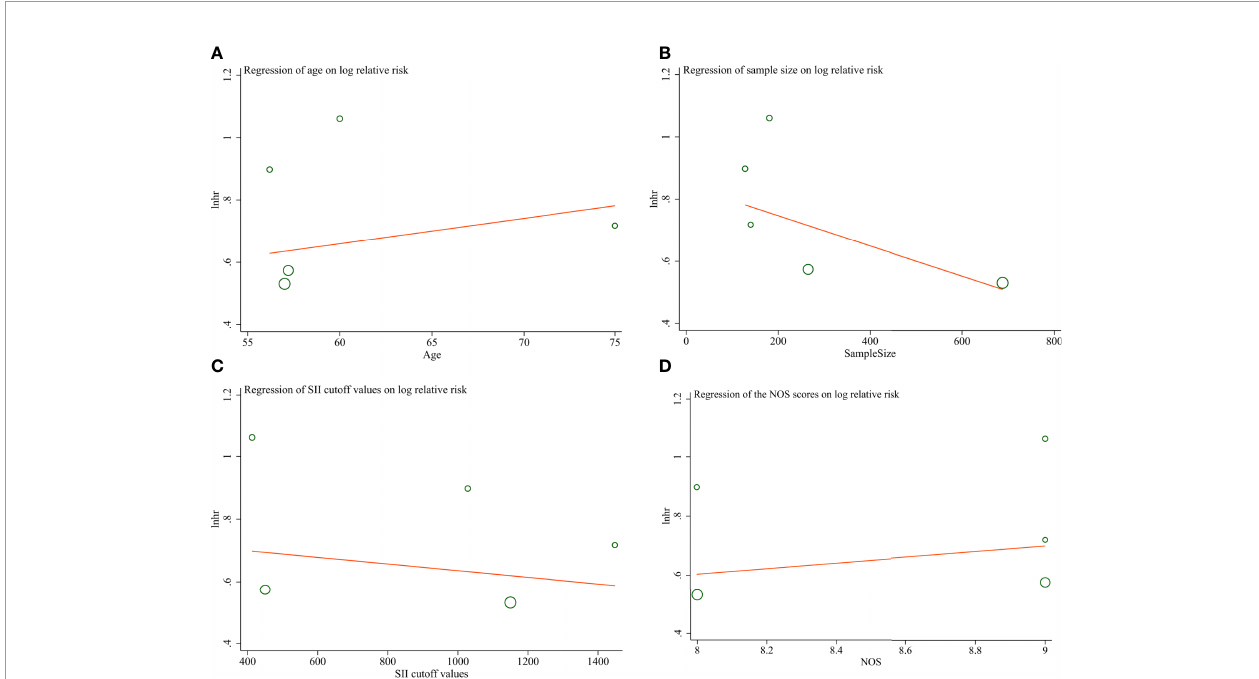
FIGURE 4 | Scattered plots for the metaregression analysis. (A) Age (B) Sample Size (C) SII cutoff values (D) NOS.